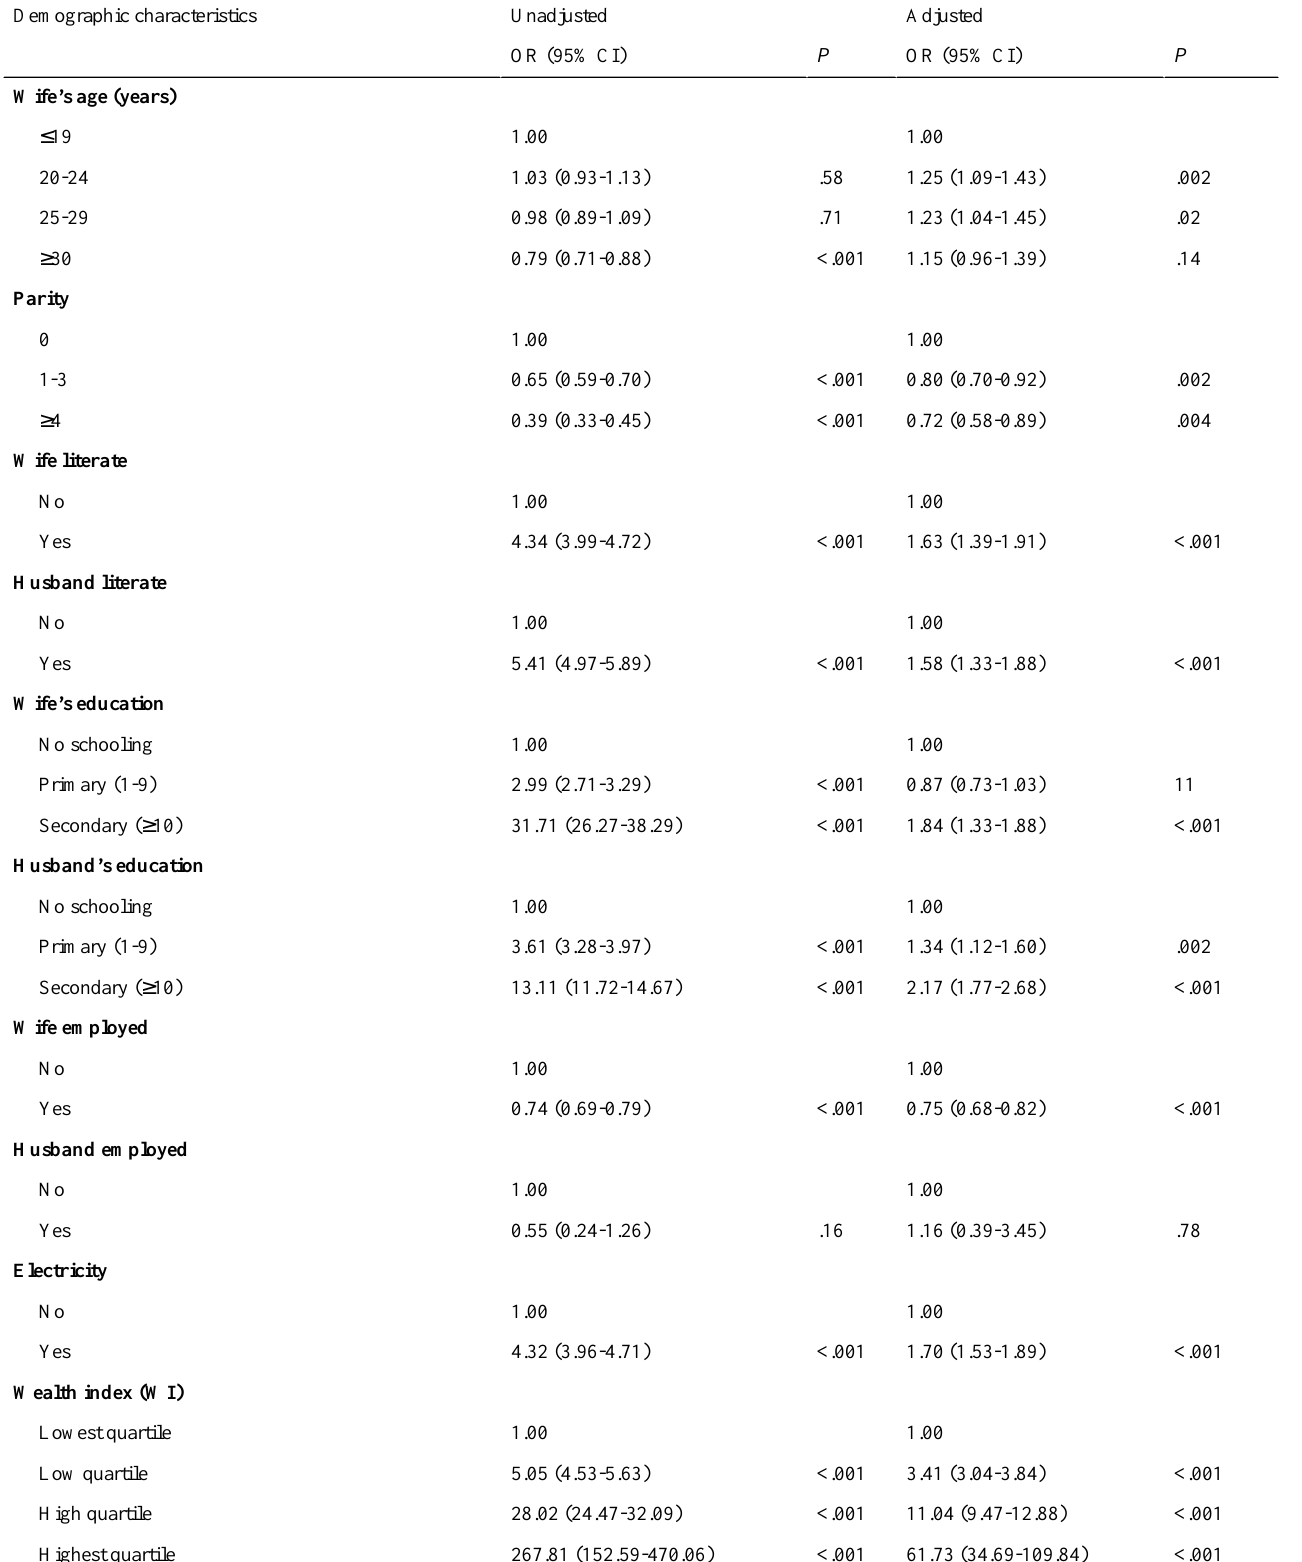
Table 4. Unadjusted and adjusted odds ratio (OR) and 95% confidence intervals (95% CI) of reporting household mobile phone ownership by demographics for fiscal year 1 (n=13,996), July 2008-June